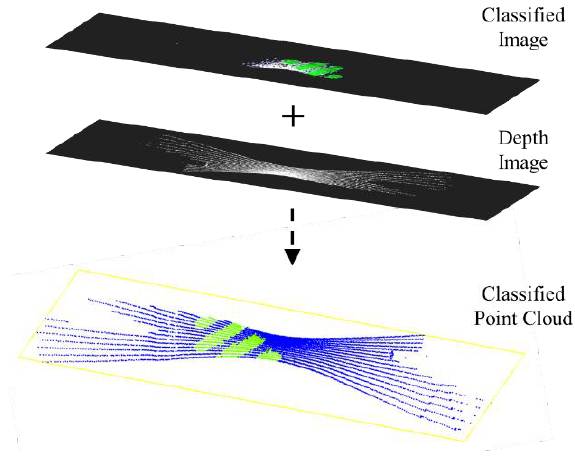
Figure 14. Point Cloud